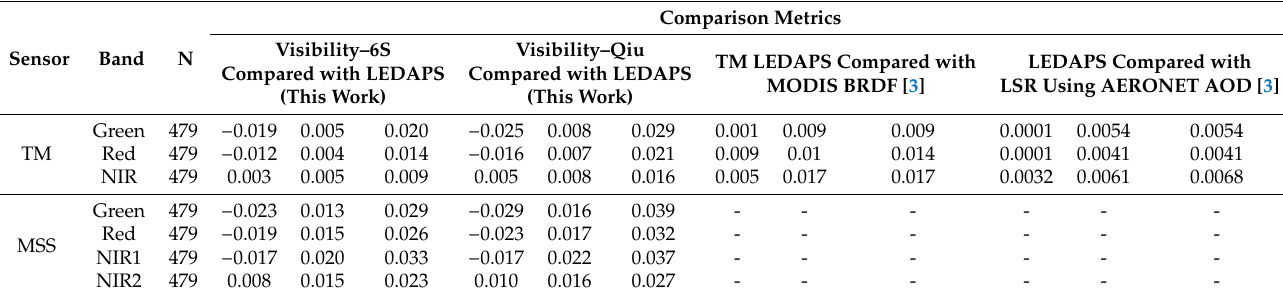
Table 4. APU scores of surface reflectance by visibility–6S method and visibility–Qiu method (compared with TM surface reflectance APU [3]).